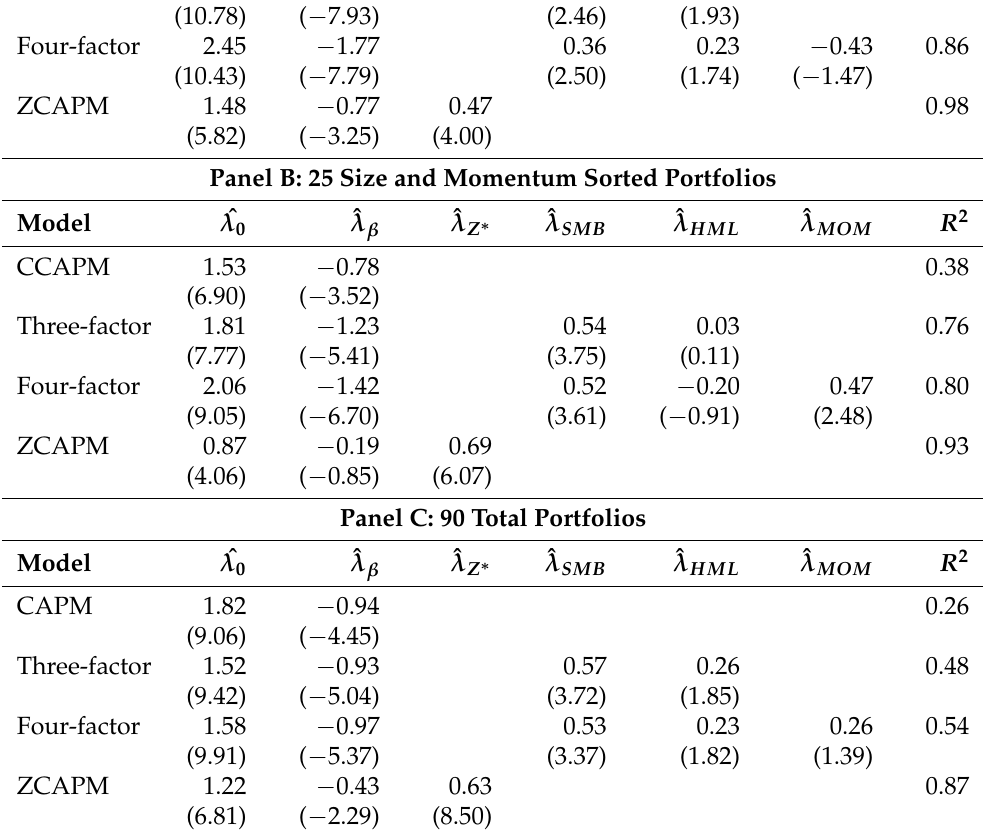
Panel A: 25 Size and BM Sorted Portfolios